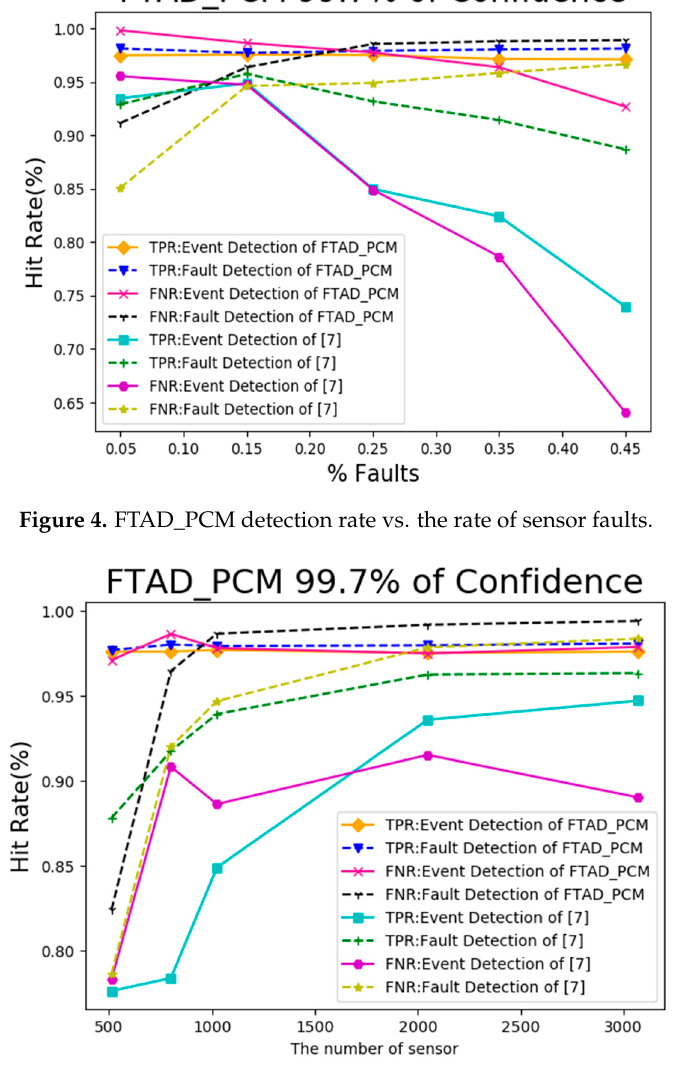
Table 3. FTAD vs. KPCA and FDS.